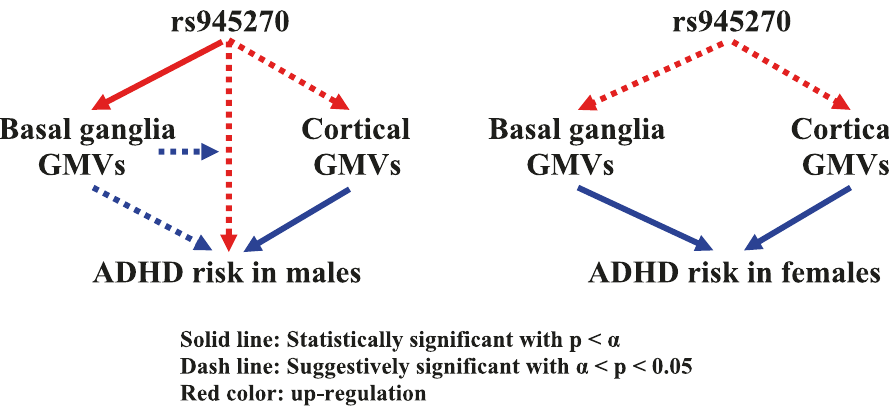
Fig. 1 Regulation pathways for rs945270, GMVs, and ADHD risk. [In males, the major allele C of rs945270 signi fi cantly ( p < α ) and suggestively ( α < p < 0.05) upregulated the basal ganglia and cortical GMVs, respectively (red); the basal ganglia and cortical GMVs suggestively and signi fi cantly downregulated ADHD risk, respectively (blue); and the allele C suggestively upregulated ADHD risk, which was repressed by basal ganglia GMVs. In females, the allele C suggestively upregulated the basal ganglia and cortical GMVs (red); and the basal ganglia and cortical GMVs signi fi cantly downregulated ADHD risk (blue).].